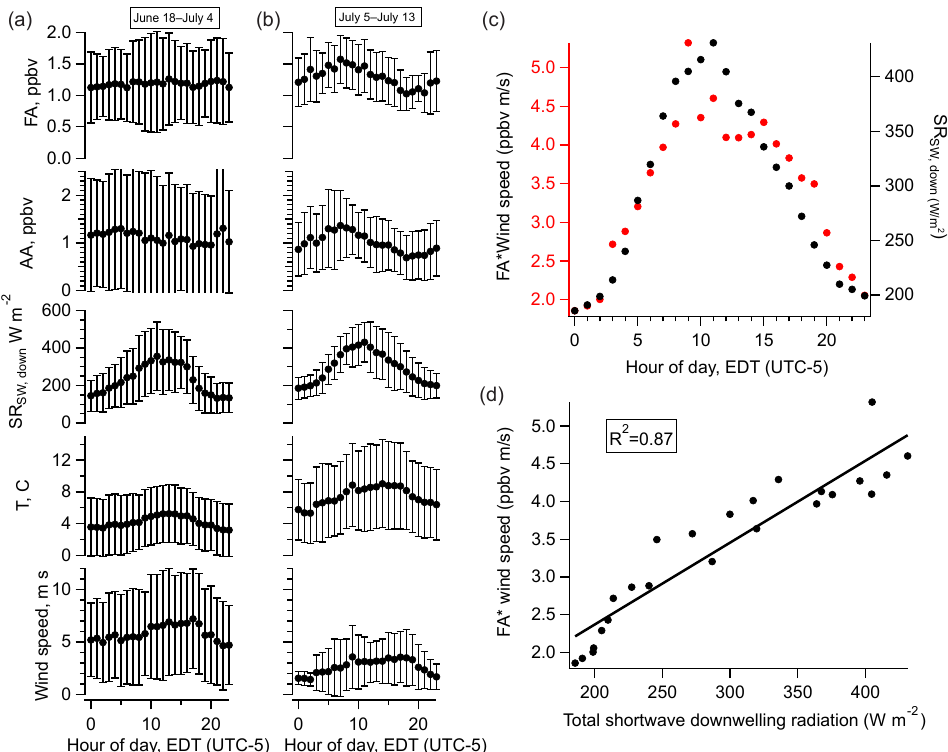
Figure 6. (a) Diurnal cycles of FA, AA, total downwelling shortwave radiation, temperature, and wind speed averaged over the entire campaign; (b) averaged over the period 5–13 July 2016; (c) the diurnal cycle of FA weighted by that of wind speed (red, left axis) and the diurnal cycle of total downwelling shortwave radiation (black, right axis); (d) the relationship between the quantities plotted in (c) . Error bars in (a) and (b) represent one standard